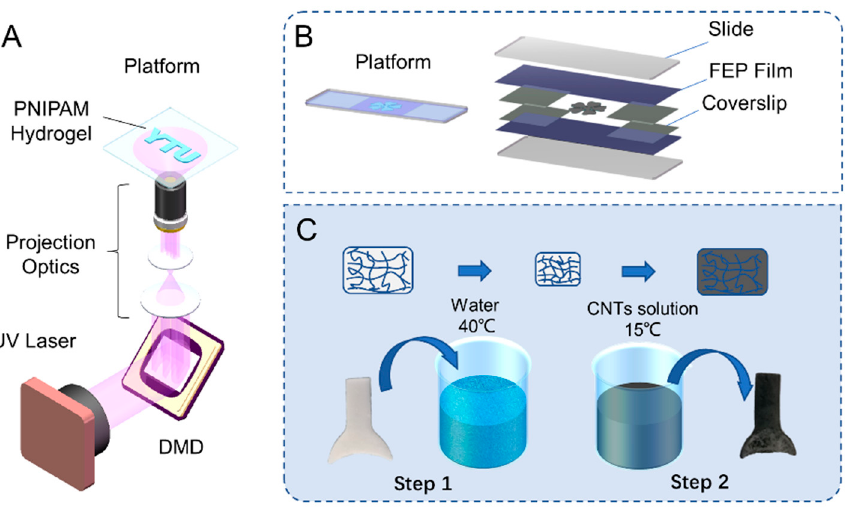
Figure 1. ( A ) Schematic diagram of the light-curing system based on the digital micromirror device. ( B ) Customized light-curing platform for hydrogel microstructures. The hydrogel structure is cured between two FEP films to complete. ( C ) Steps of PNIPAM hydrogel impregnation of CNTs. The PNIPAM hydrogel prepolymer solution is rapidly formed on the curing platform